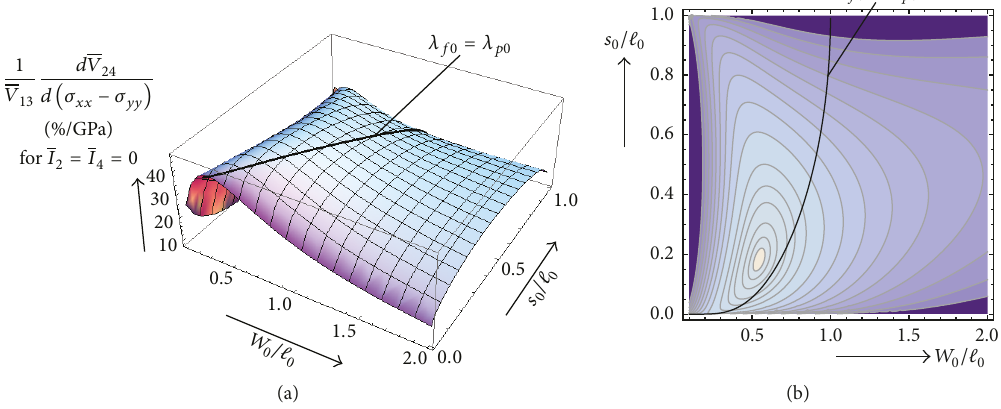
Figure 7: Sensitivity of output voltage 𝑉 24 versus mechanical stress 𝜎 𝑥𝑥 − 𝜎 𝑦𝑦 (normalized to supply voltage 𝑉 13 ) for a device of Figure 6 operated in the same way as in Figure 6. All other components of the stress tensor vanish, as well as 𝜎 𝑥𝑥 + 𝜎 𝑦𝑦 = 0 . (a) is a 3D-plot and (b) shows the contour lines thereof. In (a) the steep slopes of the surface near 𝑊 0 /ℓ 0 < 0.1 and 𝑠 0 /ℓ 0 < 0.01 and 𝑠 0 /ℓ 0 > 0.99 are only sketched due to numerical problems. The plots are graphical representations of (18a)–(18m) in the limit of small stress and with the piezoresistive coefficient 𝜋 = 1.381/ GPa for low p-doped silicon. Largest stress sensitivities are obtained for aspect ratios 𝑊 44 size is small, but 𝑠 0 /ℓ 0 ≈ 0.18 tends to be best. The black curve denotes offset-free devices with 𝜆 𝑓0 = 𝜆 𝑝0 , where 𝑉 24 = 0 at zero stress. The maximum of the surface does not lie on this curve. The contours in (b) are for 46.75, 46.5, 46, 45, 44, 42.5, 40, ... , 22.5,